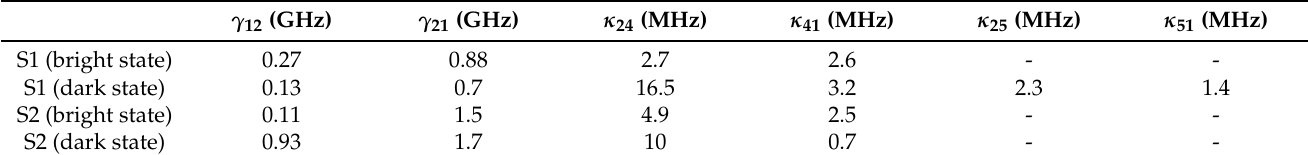
Table 1. Simulated transition rates for the S1 and S2 emitters in the dark and bright